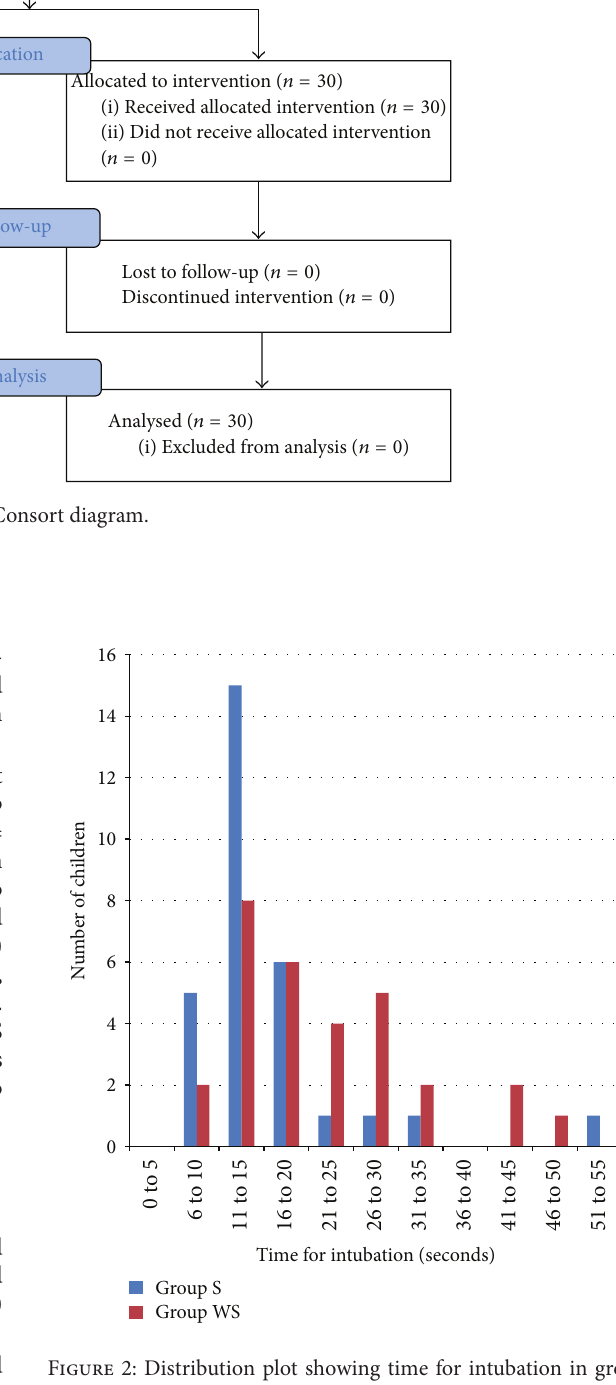
Figure 2: Distribution plot showing time for intubation in group WS and group